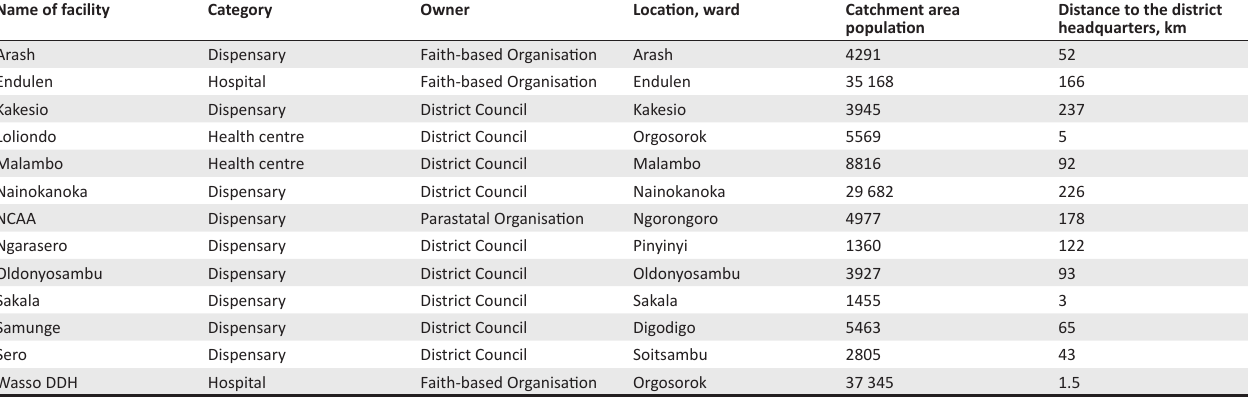
TABLE 2: Health facilities and wards visited during assessment of surveillance systems in Ngorongoro district. Name of facility